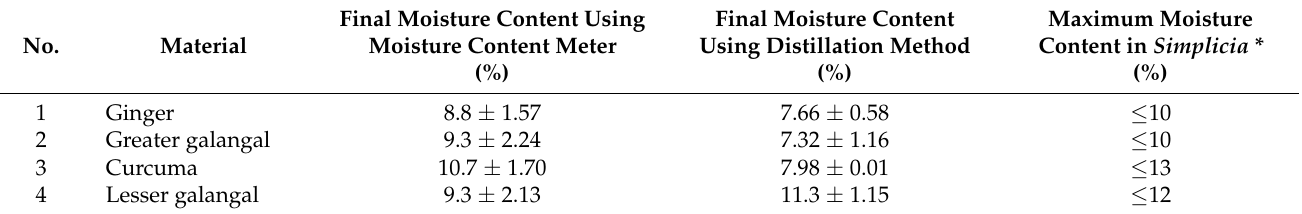
Table 3. Summary of moisture content in final products of different medicinal plant samples dried in the Polydryer with a heater measured using a moisture content meter and distillation